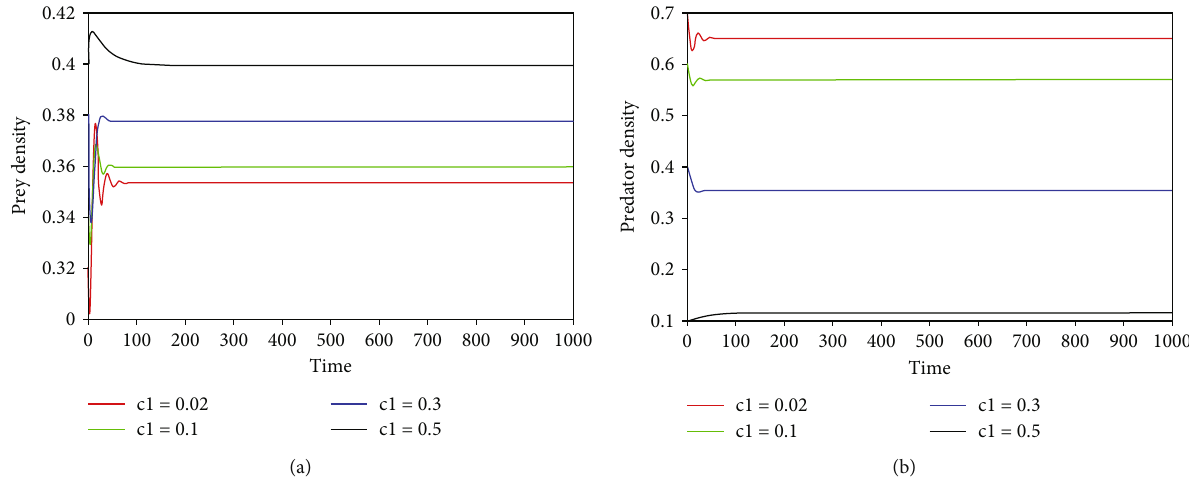
Figure 2: (a) The time series solution of system (4) approaches locally asymptotically to the equilibrium point E Table 2 except c 2 = 0 : 05, c 1 = 0 : 7, α = 0 : 25, and β = 0 : 2 , (b) The time series solution of system (4) approaches to the equilibrium point E 0 except c 2 = 0 : 05, c 1 = 1, α = 0 : 25, and β = 0 : 2